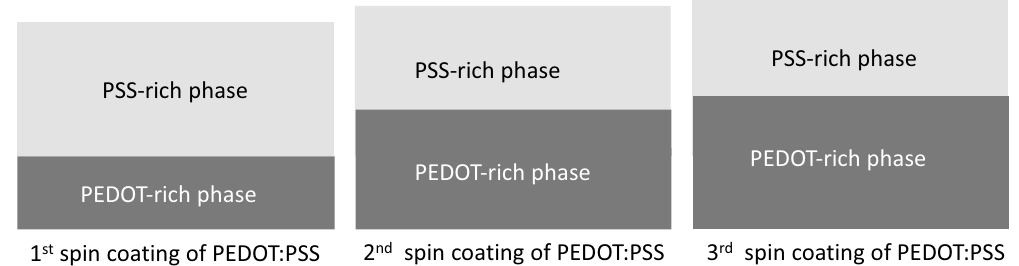
Figure 4. Explanation of how multiple PEDOT:PSS coatings enhance the electrical conductivity of the film. As explained in the text, the thicknesses of a double layer, and a triple layer increase only very slightly over the thickness of a single layer. The multiple coatings help to supplant the PSS top portion of the layer with PEDOT:PSS ribbons.